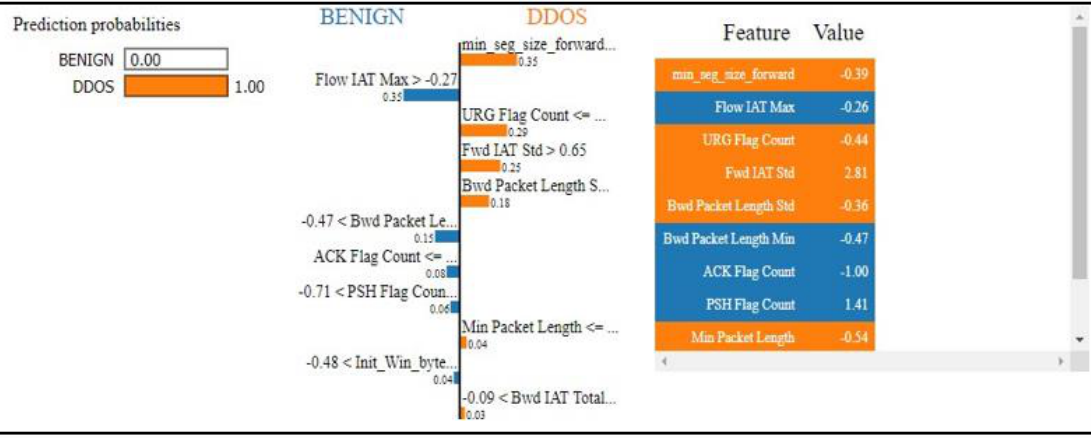
Figure 17. LIME observations for support vector machine.